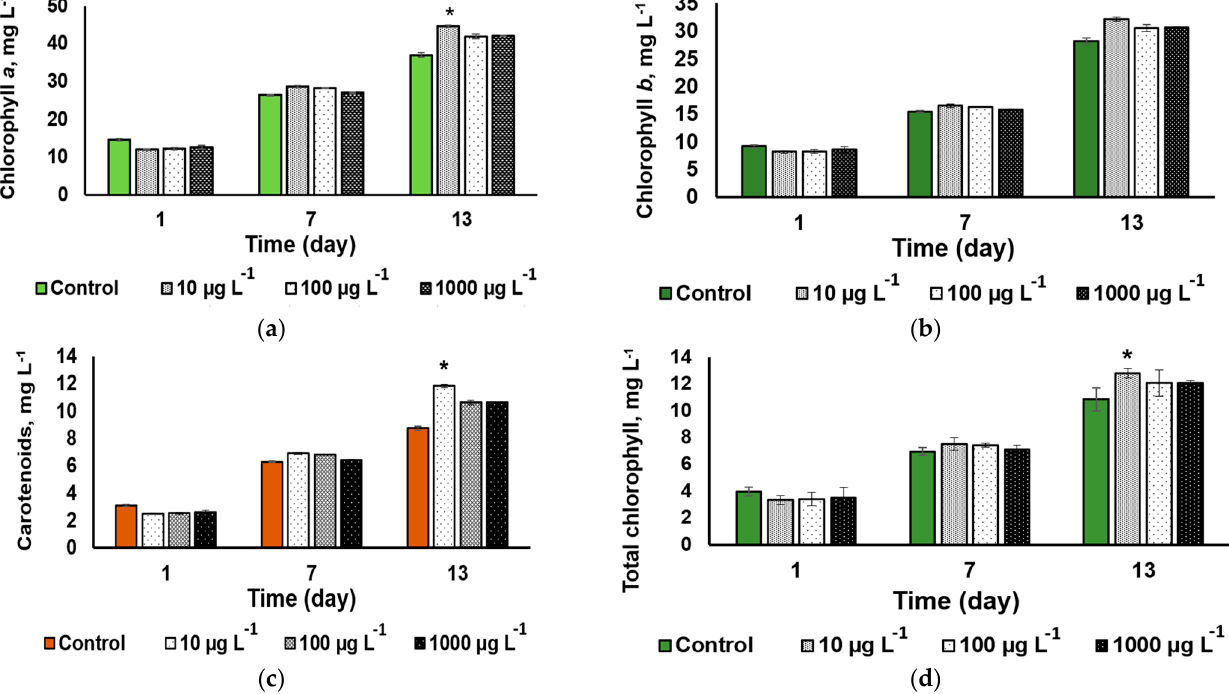
Figure 6. The dynamics of ( a ) chlorophyll a , ( b ) chlorophyll b , ( c ) total carotenoid, and ( d ) chlorophyll a + b contents in the cultures of Desmodesmus sp. incubated in the presence of different concentrations of CuO-NP. (Values significantly differing from the control are marked with an asterisk, *).